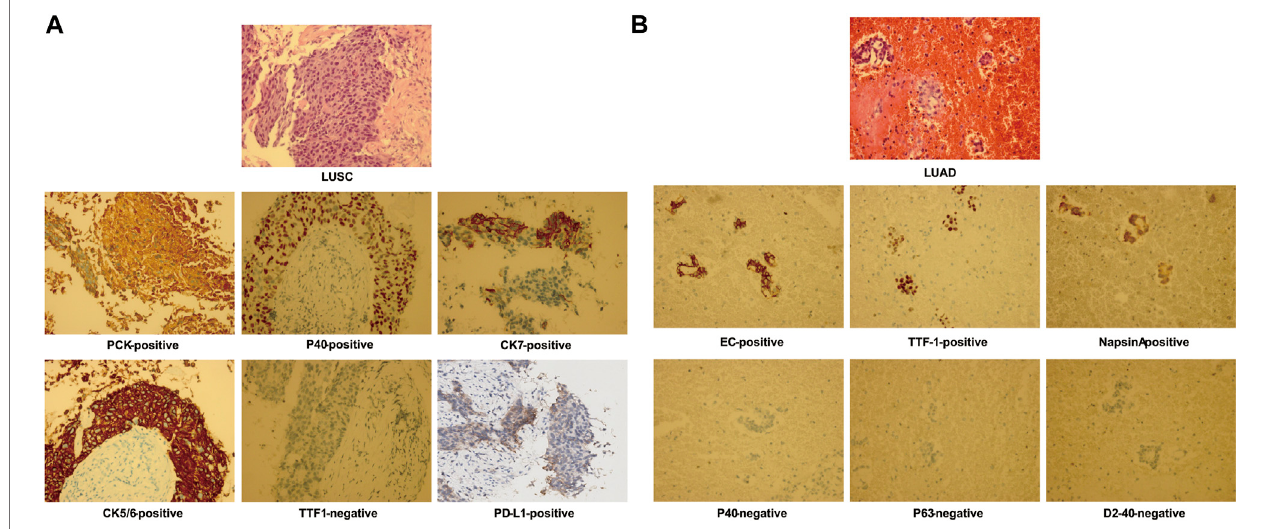
FIGURE1| Hematoxylin – eosinstainingandimmunohistochemistrystainingfrompulmonarybiopsyshowslungsquamouscellcarcinoma(LUSC) (A) andofpleural fl uid – exfoliated cells shows lung adenocarcinoma (LUAD) (B) .